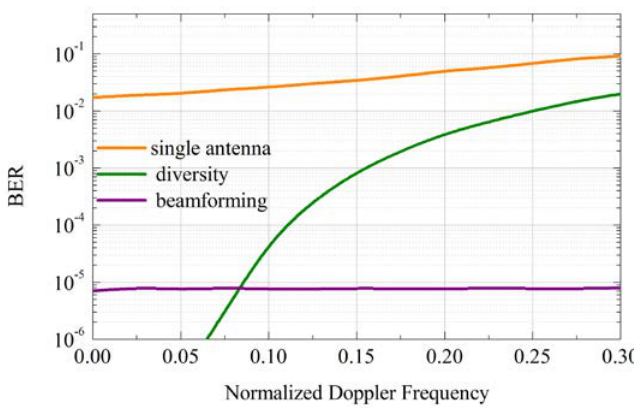
Figure 11. Relationship between BER and normalized Doppler frequency.